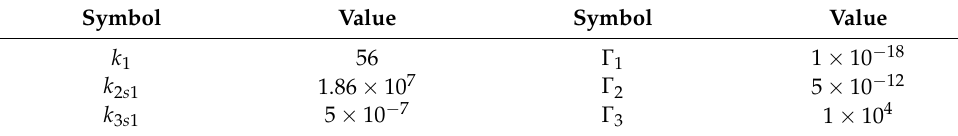
Table 5. Parameters of